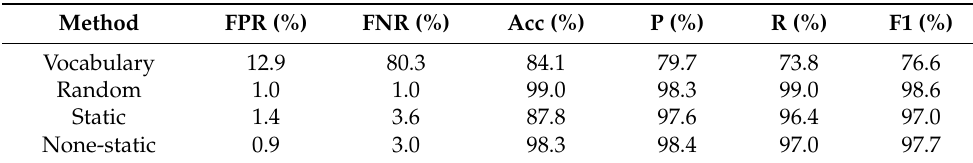
Table 3. Comparison of 4 different embedding